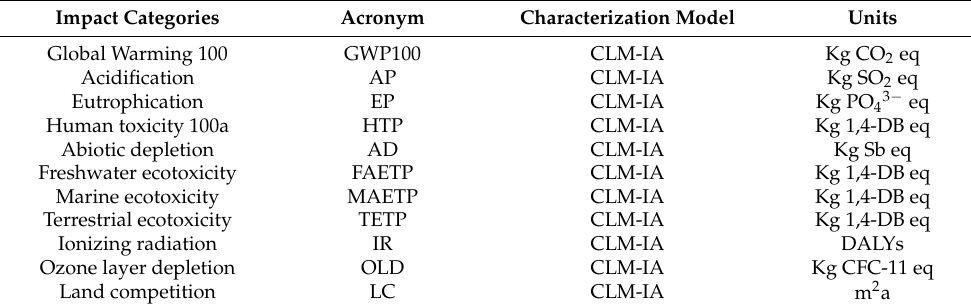
Table 1. The impact categories analyzed in this